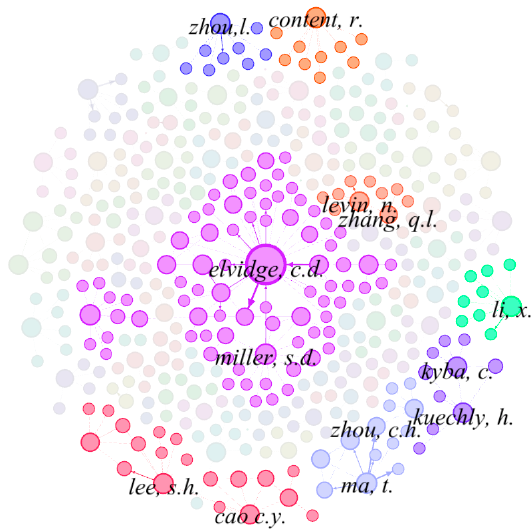
Figure 3. Top eight research communities. Table 4. Leading authors in the research community by BC rankings.